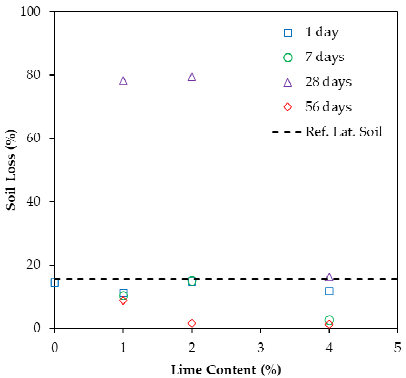
Figure 9. Percentage of soil mass loss versus lime content. Lateritic soil reference (Ref. Lat. Soil) = untreated soil; Δ w = water content variation; Sol.1% = 1% of lime saturated solution.